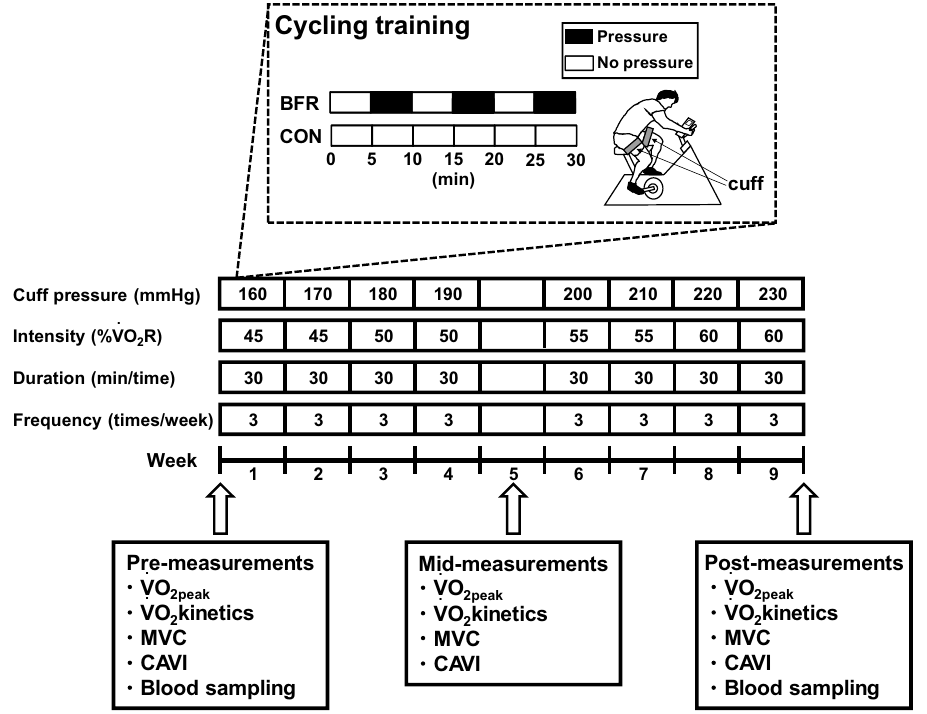
Figure 1. Schema of the training protocol and measurements The participants were randomly assigned to either group: 8-week aerobic cycle training with (BFR group) or without (CON group) blood flow restriction (BFR) and trained for 30 min, 3 days a week for 8 weeks. Cycle training did not occur during the fifth week, and mid-measurements were collected. In the BFR group, cuffs were worn on the upper thighs, and pressure was applied for 5 min every 10 min of exercise. Peak oxygen uptake ( parameters during moderate-intensity constant-load exercise, maximal voluntary contraction (MVC) force in knee extensors, and cardio-ankle vascular index (CAVI) were assessed before (Pre) and after 4 (Mid) and 8 (Post) weeks training. In addition, blood from each participant was sampled in Pre and Post to evaluate markers of coagulation and